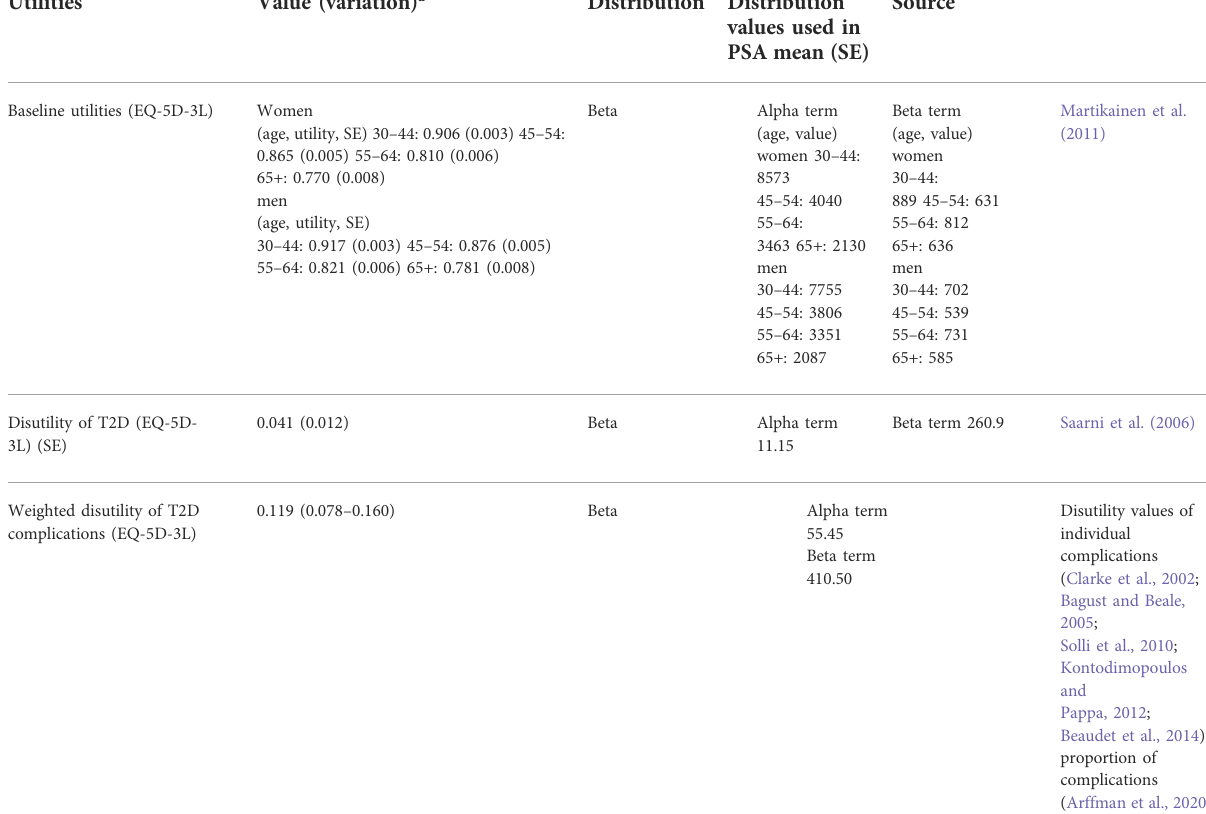
TABLE 3 Utility parameters applied in the Markov model, their distributions and the values used to estimate the distributions. Utilities